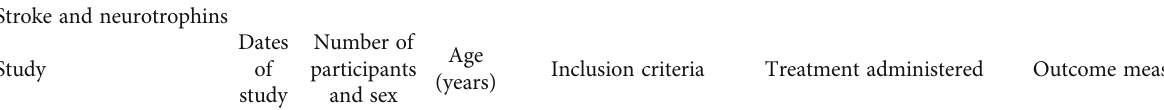
Table 1: Impact of neurotrophins on outcome measures in human